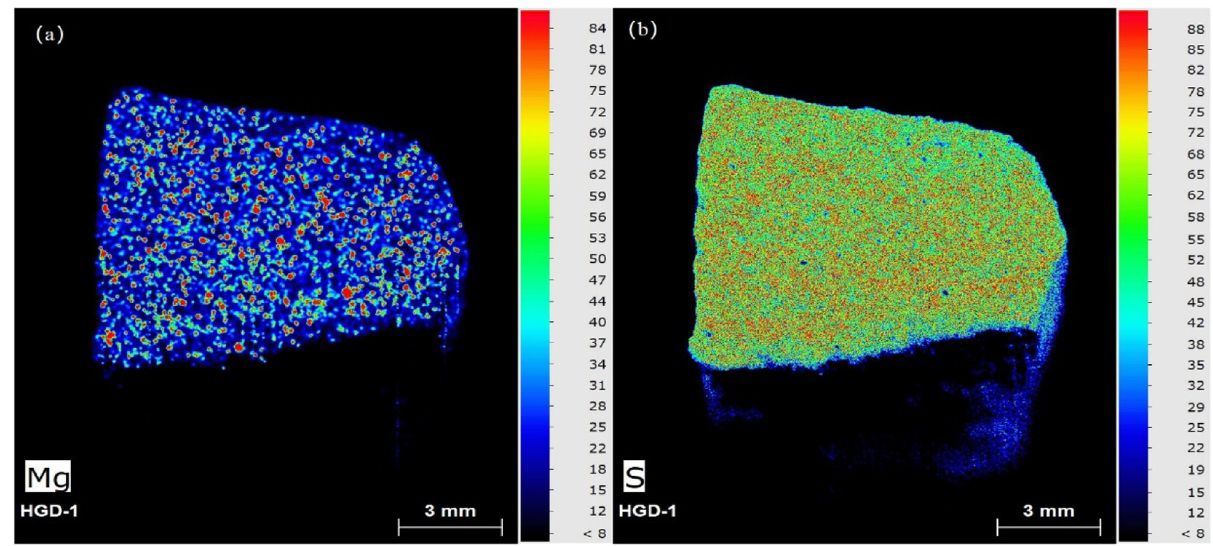
Figure 11: XRF scan result of CS3L5: ( a ) Mg and ( b )